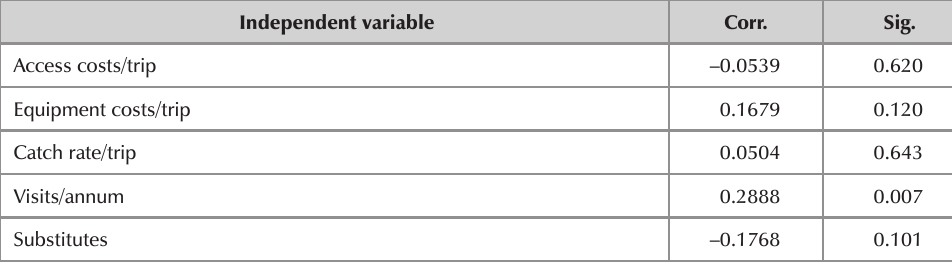
Partial correlation of WTP with all independent